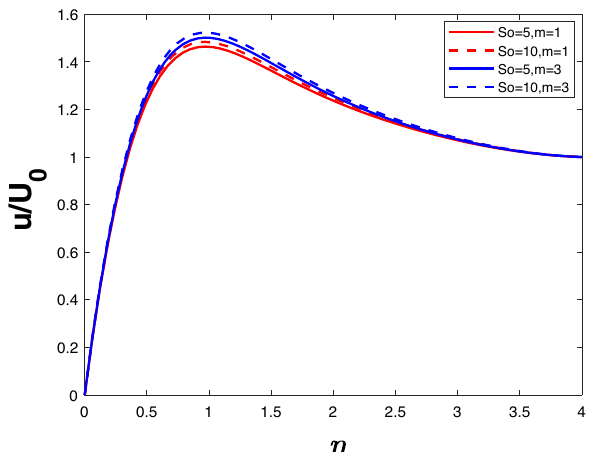
Figure 8. Velocity profile for various So .